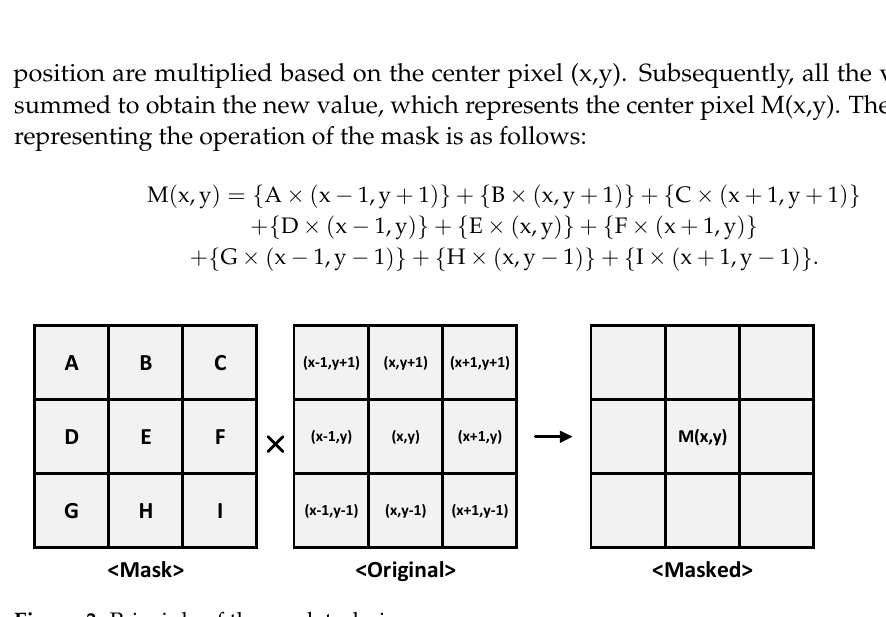
Figure 3. Principle of the mask technique.